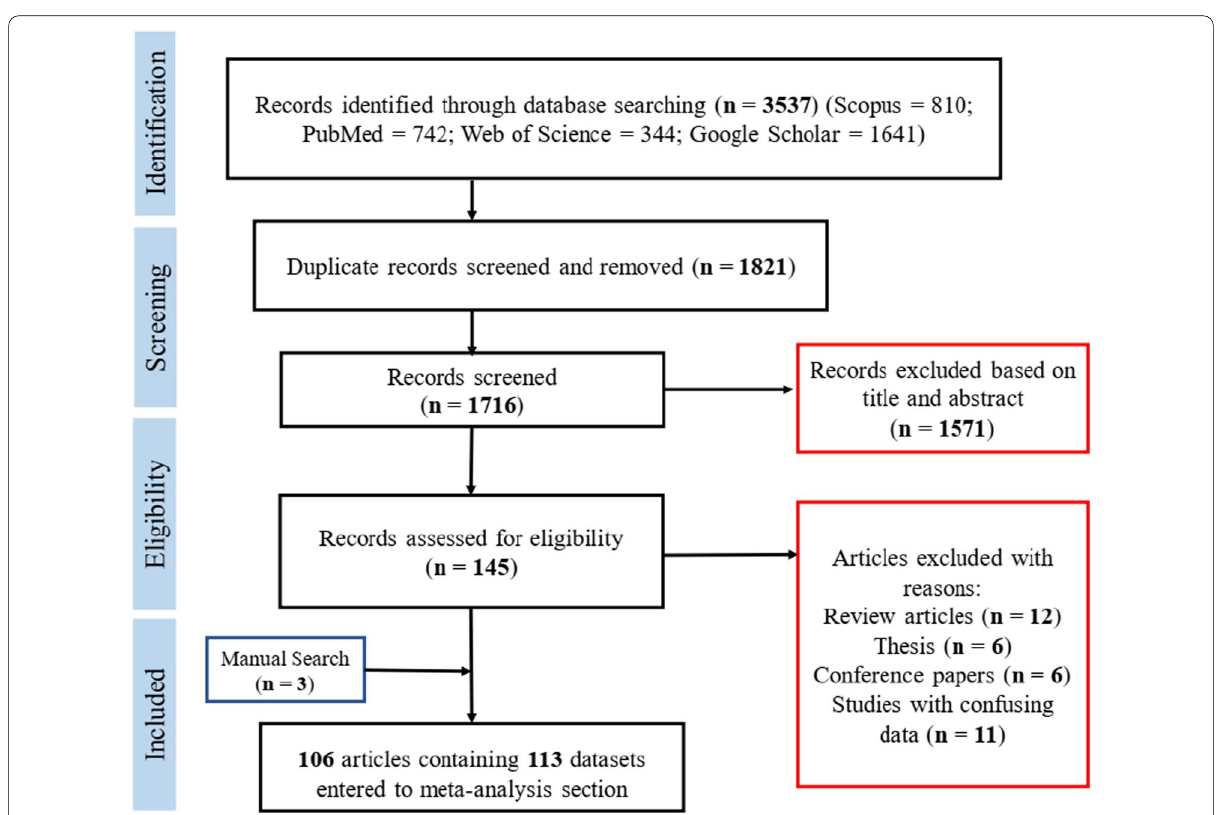
Fig. 1 PRISMA flow diagram describing included/excluded studies on FUS prevalence